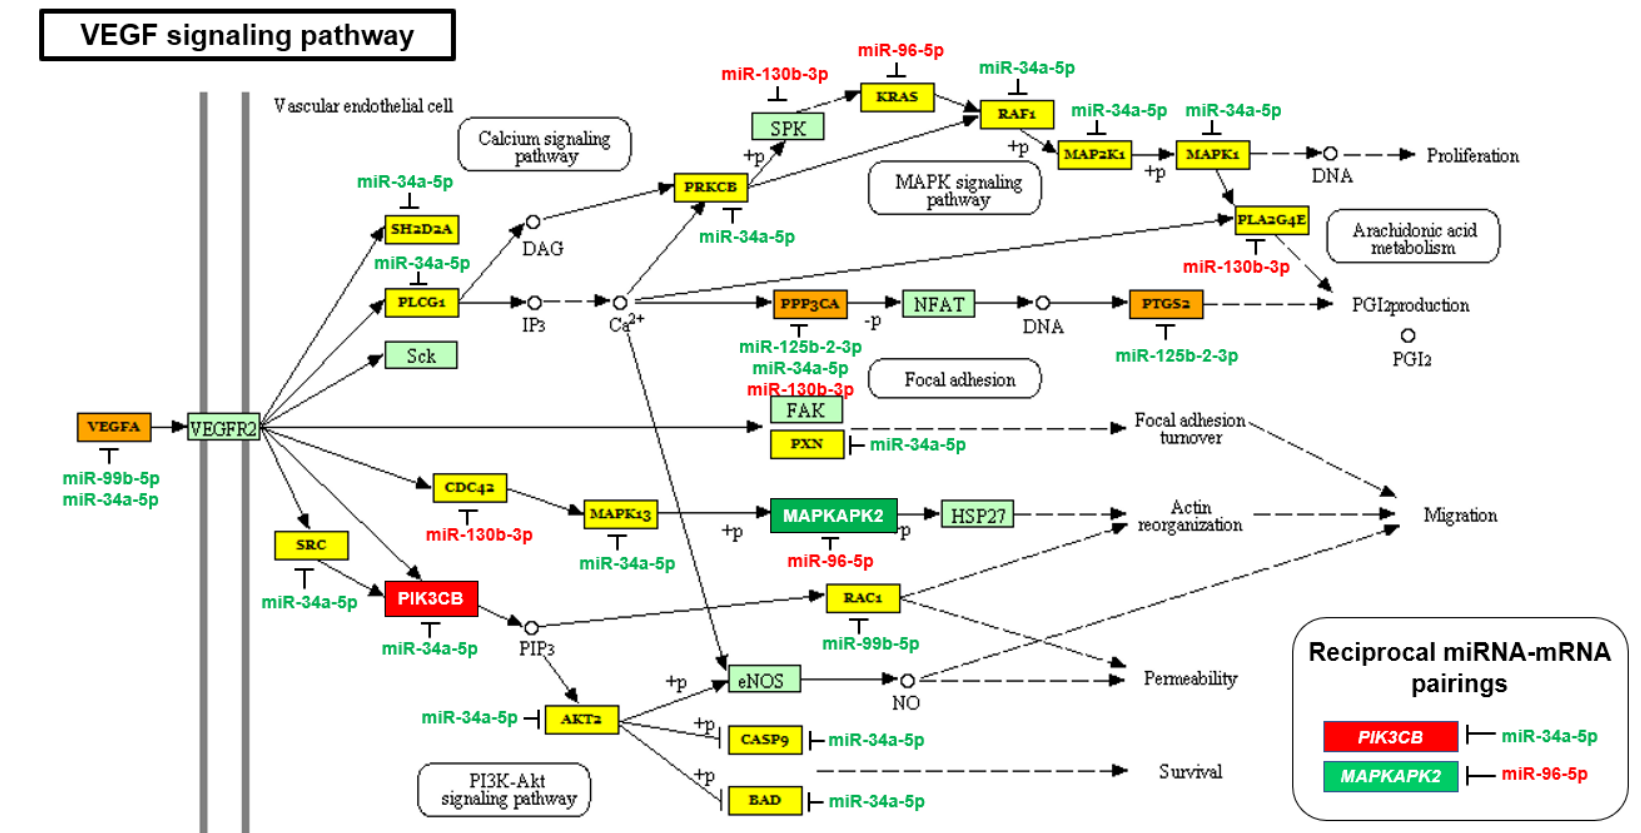
Figure 6. VEGF signaling pathway is upregulated in AA PCa specimens. Using mirPath v.3, VEGF signaling was identified as significant signaling pathway differentially regulated by AA depleted/enriched miRNAs (adjusted p -value = 0.0155). Downregulated (green) and upregulated (red) miRNAs and mRNAs, in AA PCa vs. EA PCa, were mapped in VEGF signaling pathway. Two reciprocal miRNA-mRNA pairings, PIK3CB /miR-34a-5p (up/down) and MAPKAPK2 /miR-96-5p (down/up), were highlighted. Other unpaired downregulated and upregulated miRNAs (miR-125b-2-3p, miR-99b-5p and upregulated miR-130b-3p) were indicated next to their predicted target genes. The genes highlighted with yellow are genes targeted by one AA-depleted/enriched miRNA. The genes highlighted with orange are genes targeted by at least two AA-depleted/enriched miRNAs. The genes highlighted with light green are genes not targeted by any AA-depleted/enriched miRNA.